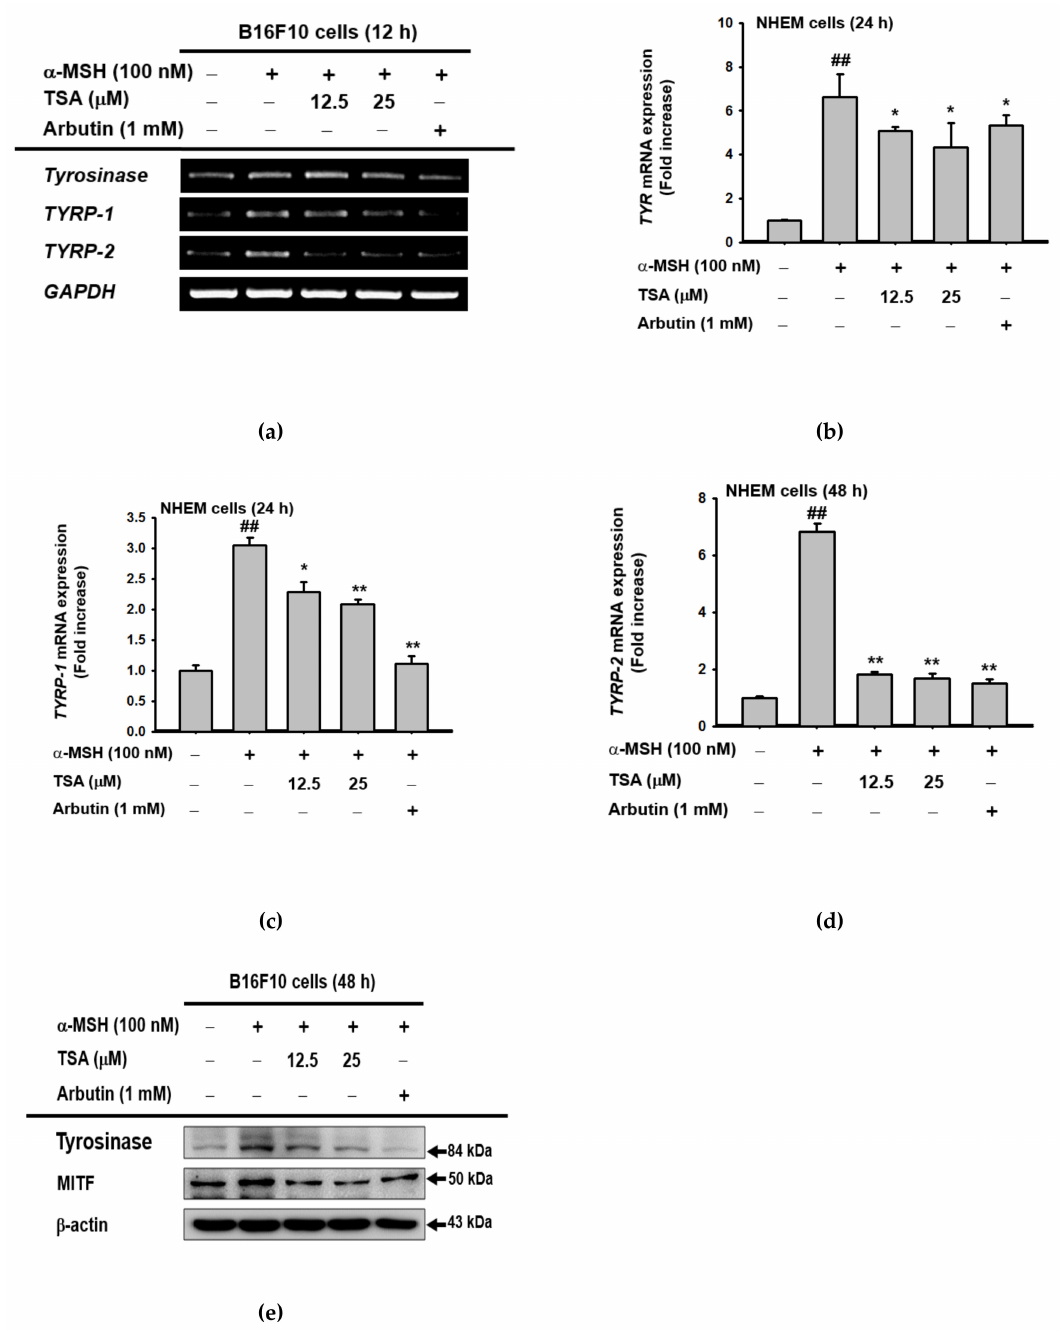
Figure 3. The effect on transcriptional events of melanogenesis. ( a–d ) The mRNA expression of Tyr , Tyrp1 , and Tyrp2 in B16F10 or NHEMs treated with TSA (12.5–25 µ M) or arbutin (1 mM) in response to α -MSH for 24 or 48 h were determined using RT-PCR and real-time PCR analyses. ( e ) Protein levels of tyrosinase and MITF in TSA (12.5–25 µ M)- or arbutin (1 mM)-treated B16F10 cells, in response to α -MSH for 48 h of TSA, were determined using Western blotting analysis. For all applicable experiments, statistical significance was evaluated using the Mann–Whitney U test. All experiments were performed at least three times. +: indicates treatment, − : indicates non-treatment. ## p < 0.01 compared with the normal group, * p < 0.05 and ** p < 0.01 compared with the control